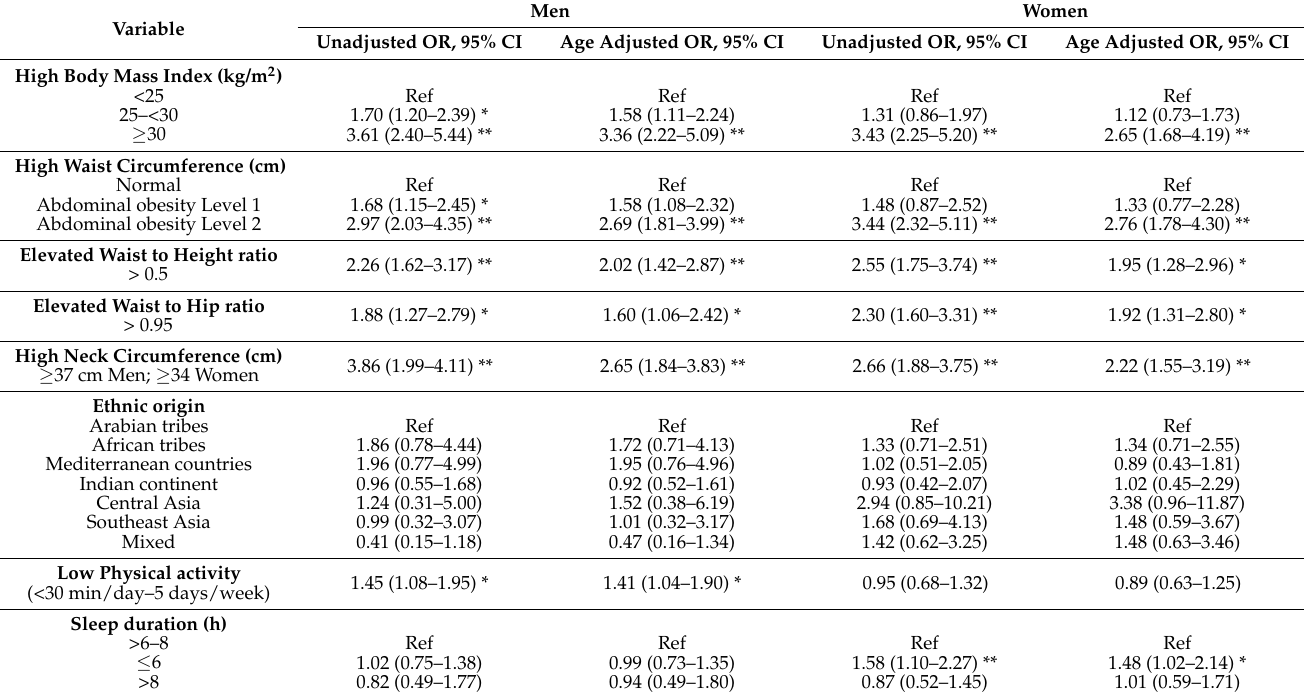
Table 4. Unadjusted and age-adjusted odds ratio (OR), and confidence interval (CI) for anthropometric measurements and lifestyle habits covariates associated with people with prehypertension and hypertension